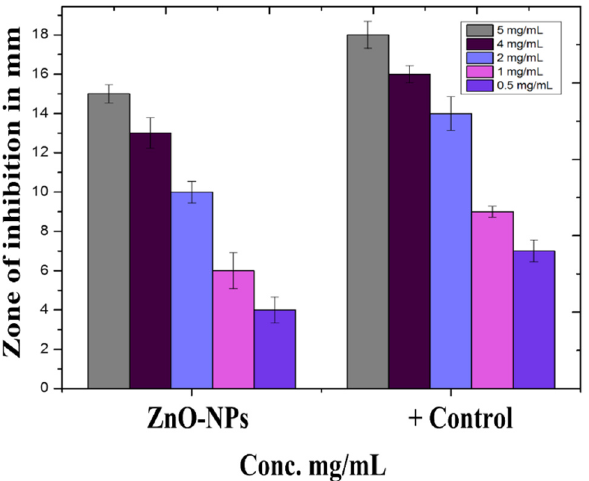
Figure 8. Protein Kinase Inhibition (in mm) by ZnO-NPs.